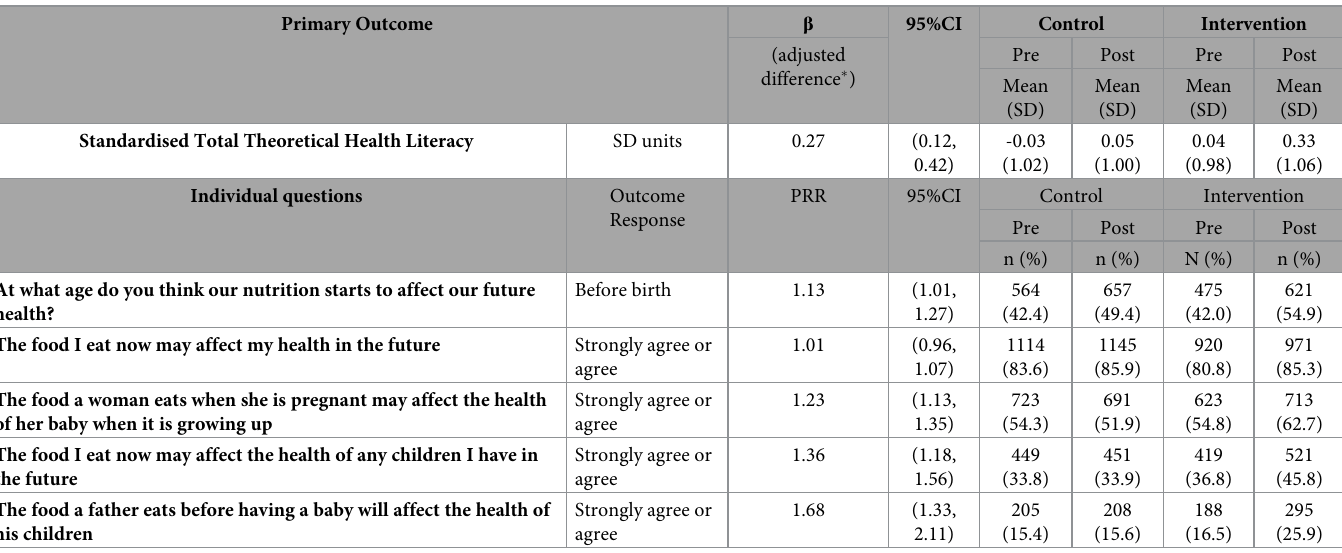
Table 2. Change in the primary outcome of theoretical health literacy score.